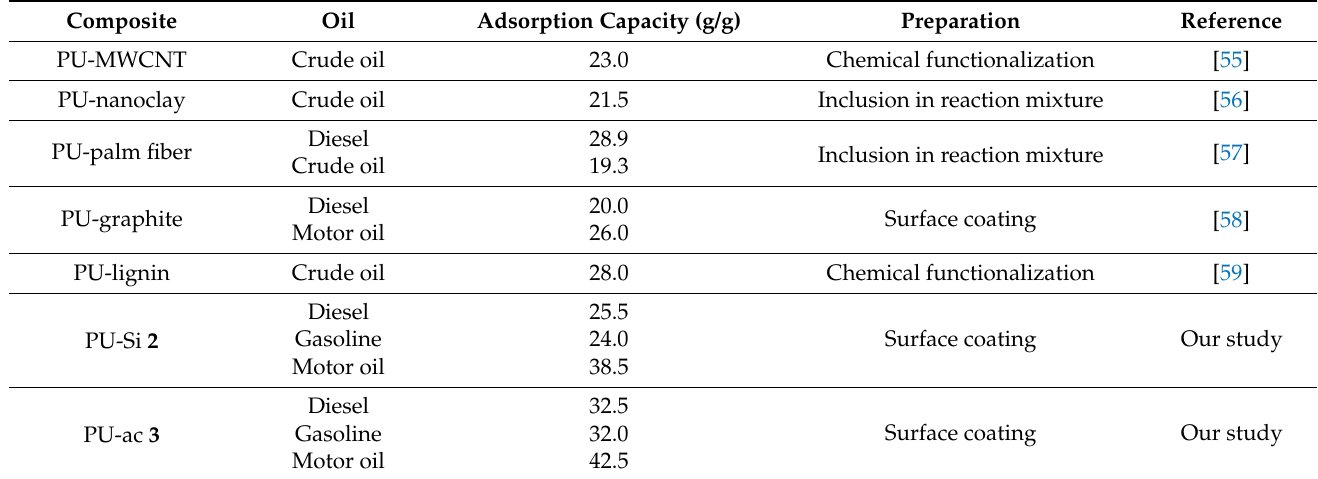
Table 1. A comparison between the materials reported in the literature and composites 1–3 tested in this